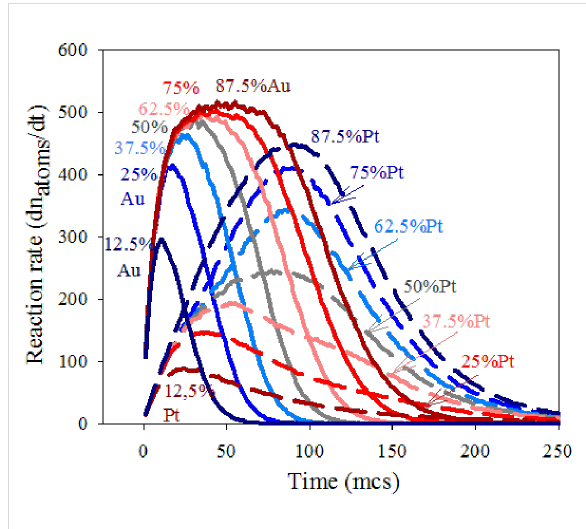
Figure 4: Reaction rate versus time. Continuous and discontinuous lines show the resulting Au and Pt, respectively. Synthesis conditions: flexible film ( k ex = 5, f = 30), reduction rate ratio v Au /v Pt = 10; average concentration = 64. Scheme color: dark blue lines: 12.5% Au, = 16, = 112; medium blue lines: 25% Au, = 32, = 96; light blue lines: 37.5% Au, = 48, = 80; grey lines: 50% Au, = 64, = 64; light red lines: 62.5% Au, = 80, = 48; medium red lines: 75% Au, = 96, = 32; dark red lines: 87.5% Au, = 112, = 16 reactants per